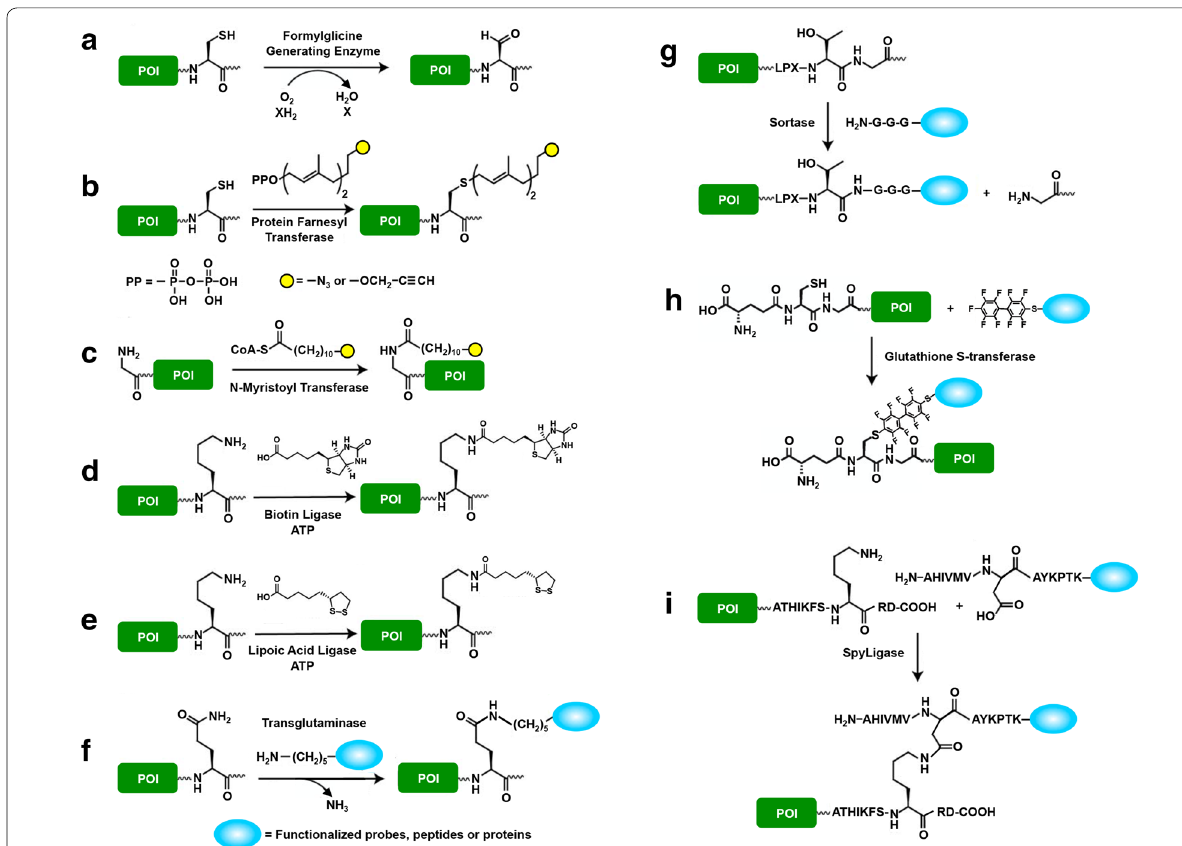
Fig. 23 Chemoenzymatic labeling strategies of the protein of interest (POI) using post-translational modification enzymes. a Formylglycine generating enzyme (FGE) recognizes LCXPXR peptide motif and converts the side chain of Cys residue into an aldehyde group. The POI fused to the aldehyde tag can be further functionalized with aminooxy or hydrazide probes. b Farnesyltransferase (FTase) recognizes the four AAs sequence